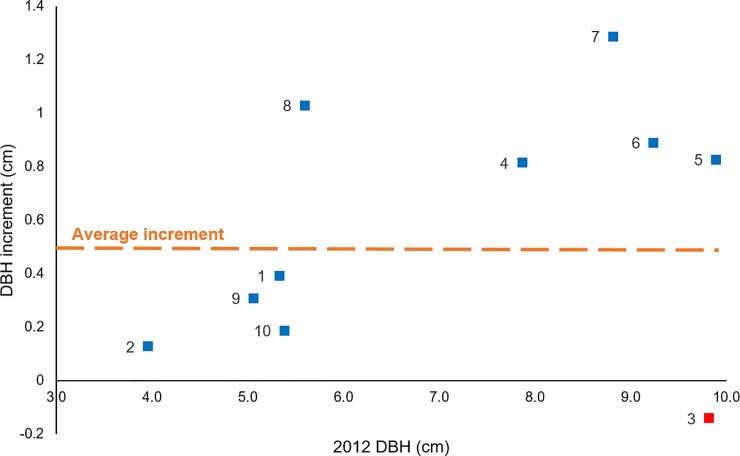
Diameter at breast height’s (DBH) increment (cm) per plot in the forest against 2012 DBH (cm).Blue squares represent the forest plots with positive DBH increment, red squares represent those with decreasing DBH. Orange dashed line is the average DBH increment among all forest plots, 0.5 cm.